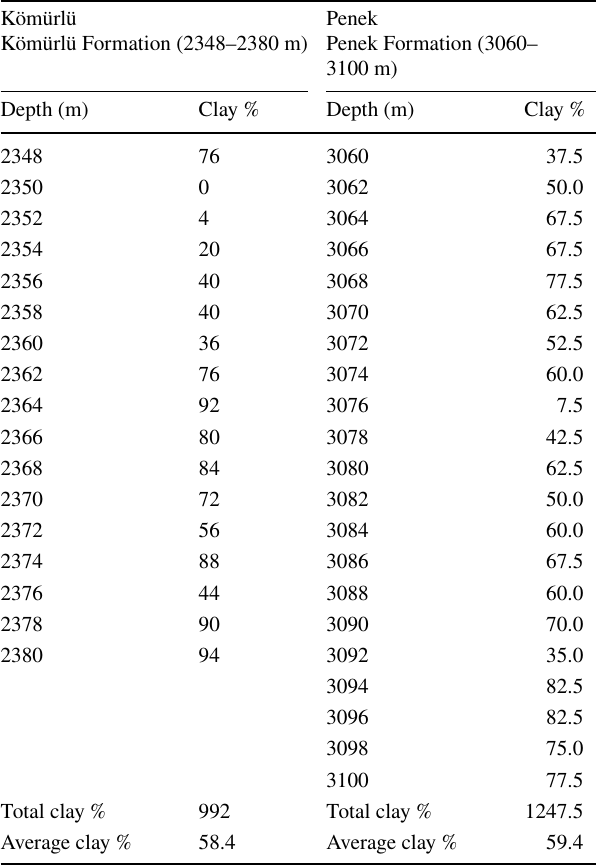
Table 3 Clay percentages of the Kömürlü and Penek Formation sand- stones, Aşkale